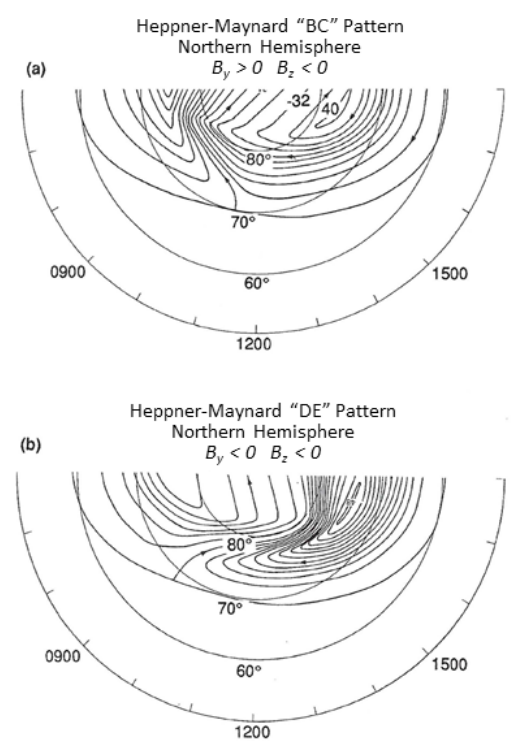
Figure 9. Dayside portions of convection maps obtained by Hep- pner and Maynard (1987), using data from the Dynamics Explorer (DE-2) spacecraft. The upper pattern (a) is observed in the Northern Hemisphere when IMF B z is negative and IMF B y is positive and in the Southern Hemisphere when IMF B z and IMF B y are negative. The lower pattern (b) is observed in the Northern Hemisphere when IMF B z and IMF B y are negative and in the Southern Hemisphere when IMF B z is negative and IMF B y is positive. How quickly do these transitions take place? Reproduced from Fig. 1 of Greenwald et al.